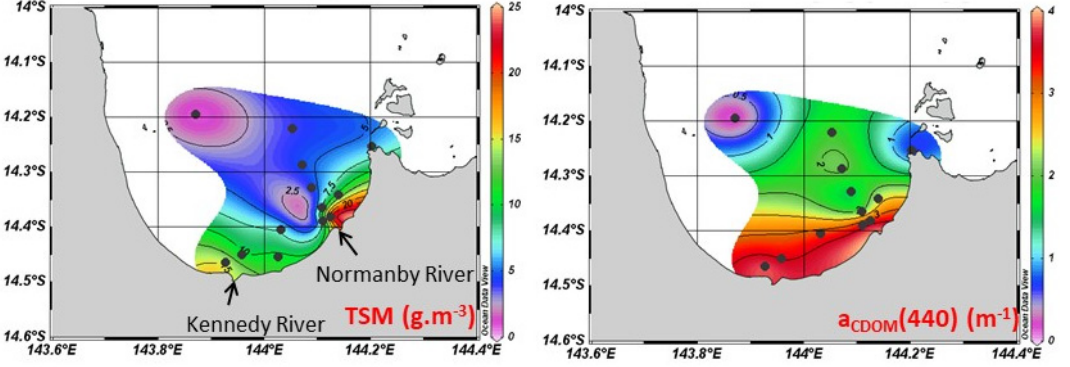
Figure 6. Spatial distribution of total suspended matter (TSM) and Colored Dissolved Organic Matter (CDOM) absorption coefficient at 440 nm (a CDOM (440)) in the surface layer. The strong biogeochemical variability was reflected in the variability of key in situ bio-optical properties, such as the particle backscattering efficiency at 550 nm (bb p /b p (550)) and the TSM-specific scattering coefficient (b*(550)) (Table 1). Both bb p /b p (550) and b*(550) are key parameters required to improve satellite ocean color algorithms. bb p /b p is an estimate of the fraction of light scattered backwards by particles and also a function of the nature of the particles. bb p /b p (550) was high in the floodwaters, with values reaching 4.7% near the Normanby mouth (st. 1088, also with the highest TSM) and 3.3% near the Kennedy mouth (st. 1092). Away from the flood plumes, bb p /b p (550) dropped down to 0.5% (st. 1095). In turn, b*(550) increased fivefold from the Normanby mouth to the north of the bay (from 0.23 to 1.05 m 2 g − 1 at st. 1088 and 1095, respectively). The Dissolved Organic Carbon concentration (DOC) was high near the Kennedy and Normanby mouths (6.88 and 5.39 g m − 3 at st. 1093 and 1088, respectively) (Table 1). By contrast, in the north of the bay and near the outer-shelf reef, DOC dropped by around a factor 6 to 7 (0.98 and 0.92 g m − 3 at st. 1095 and 1082, respectively). The absorption coefficient of CDOM a CDOM , the colored fraction of the dissolved organic matter (so-called ‘gelbstoff’ or yellow substances, [50], dropped by a factor 27 from the Kennedy mouth to the north of the bay (from 3.81 to 0.14 m − 1 at 440 nm, at st. 1093 and 1095, respectively). In floodwaters, a CDOM (440) is a good proxy for DOC. The linear relationship between a CDOM (440) and DOC is characterized by an R 2 of 0.96 ( p < 0.0001), and the intercept on the Y axis of 0.685 g m − 3 is representative of the noncolored fraction of DOC (Figure 7). The corresponding a CDOM *(440) (a CDOM (440) normalized by DOC) ranged from a maximum of 0.75 and 0.58 m 2 g − 1 near the Normanby and Kennedy mouth (st. 1089 and 1092, respectively) to a minimum of 0.15 and 0.03 m 2 g − 1 in the north of the bay and close to the outer-shelf reef (st. 1095 and 1082, respectively). The repeat station (st. 1084 and 1096) showed a significant drop in a CDOM *(440) over 42 h (from 0.54 to 0.34 m 2 g − 1 , respectively). The CDOM slope ratios (S 275–295 /S 350–400 ) were higher away from the riverine inflows, with less than 1.0 near the rivers and up to ~3.0 in the north of the bay.